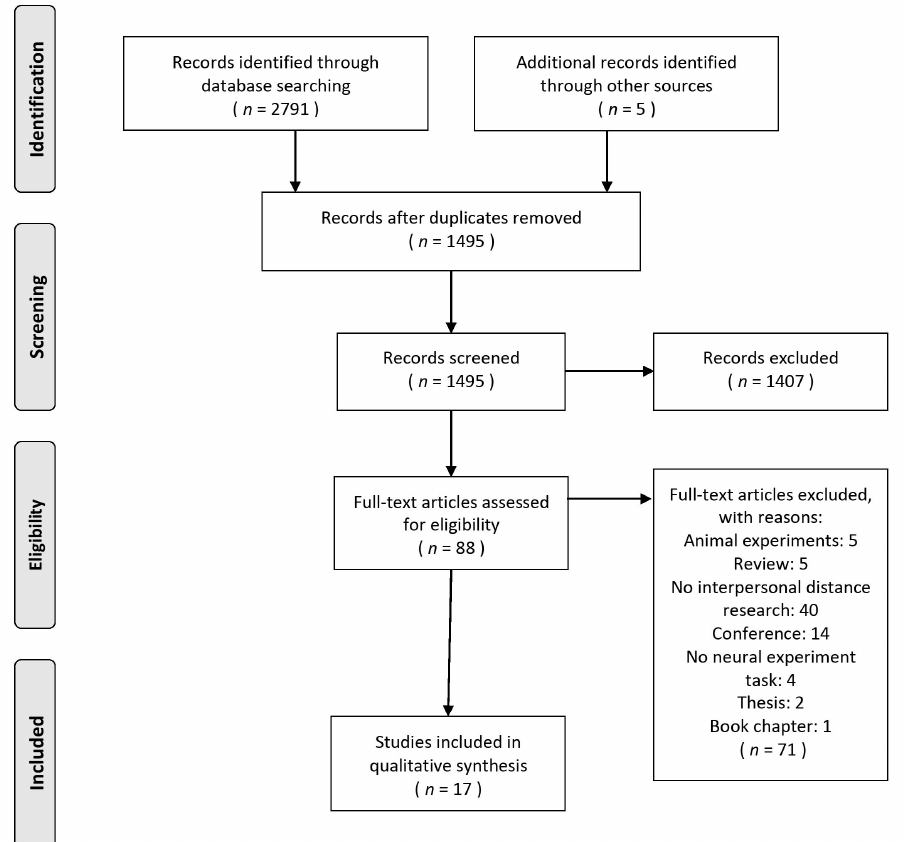
Figure 1. Flow diagram of the selection procedure.